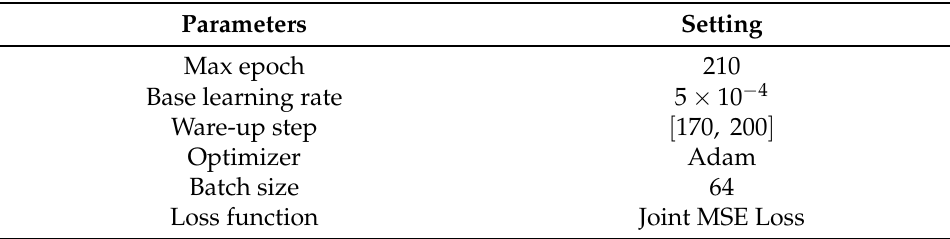
Table 3. Demonstration of experimental settings and hyperparameters.